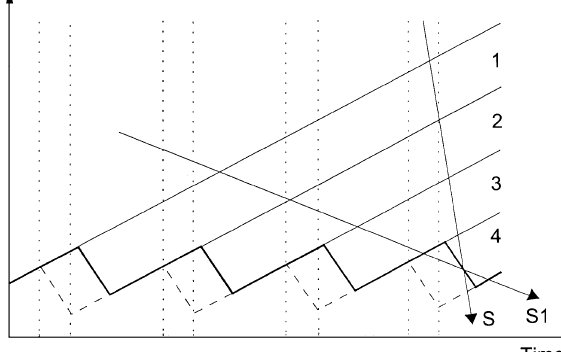
Fig. 3. Same as Fig. 1b, but showing the loci of the meridionally equatorwards-moving, low-altitude satellite, S , and a